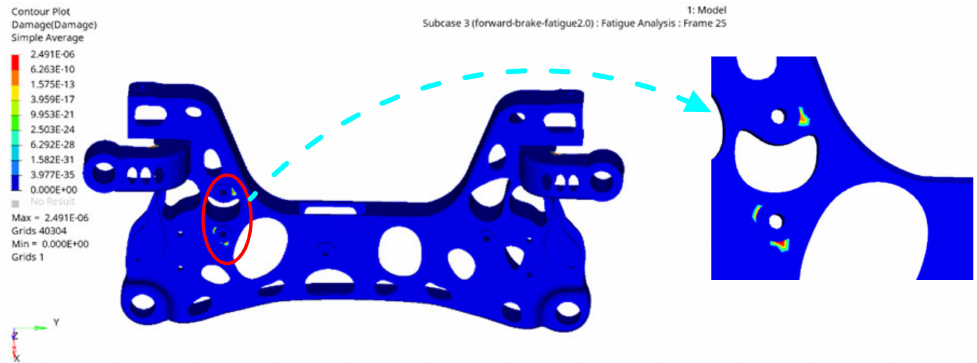
Figure 21. Fatigue damage cloud diagram of aluminium alloy front subframe under forward braking condition.